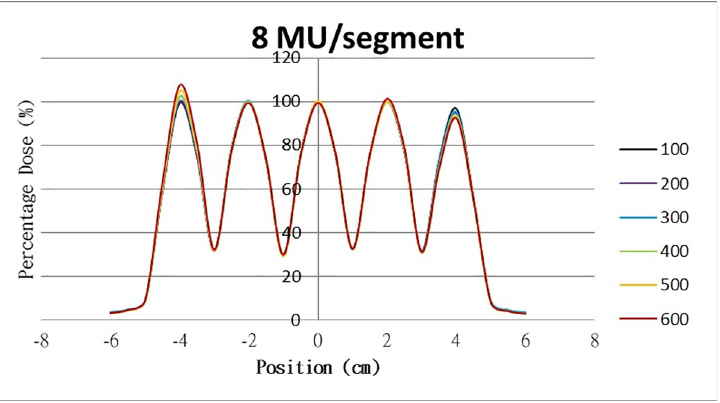
Fig 13. Overshoot effect measured at various MU values and dose rates. Overshoot effect, at various dose rates, for (6) 1 MU, (7) 2 MU, (8) 3 MU, (9) 4 MU, (10) 5 MU, (11) 6 MU, (12) 7 MU, (13) 8 MU, (14) 9 MU, (15) and 10 MU.